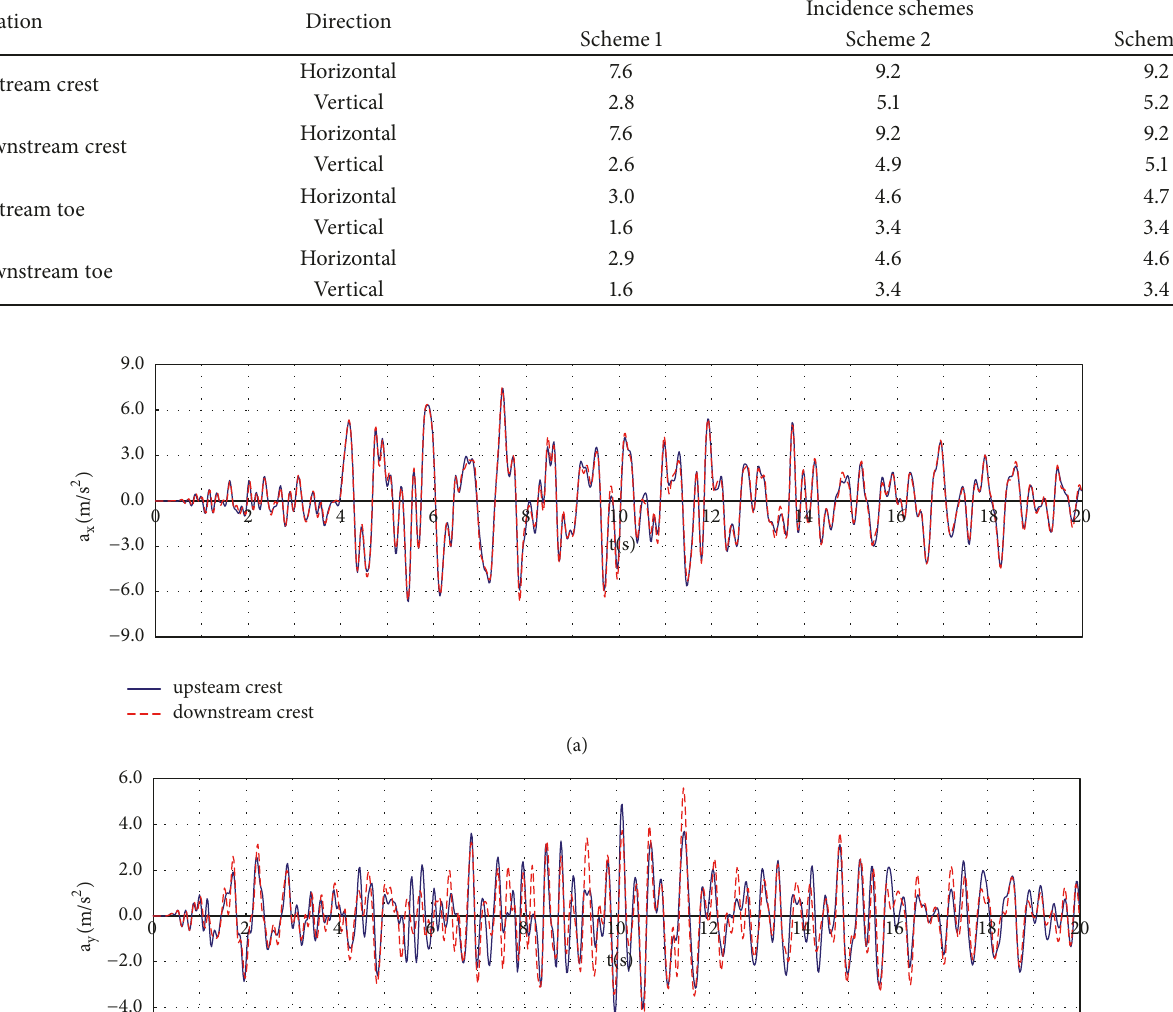
Table 5: Dynamic displacement extremums of the dam (unit: cm).